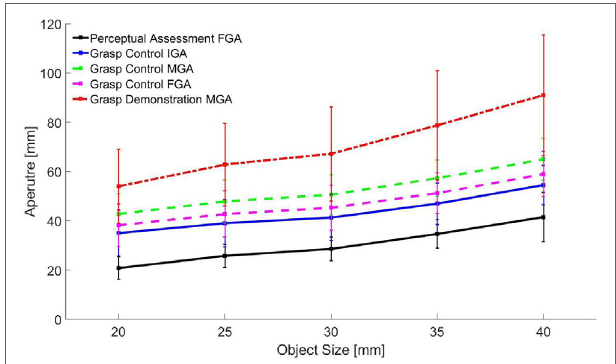
FigUre 5 | Mean of means (SD marked by crosshair) for assessment final grip aperture (FGA), grasp control initial grip aperture (IGA), FGA, and maximum grip aperture (MGA), and grasp demonstration MGA.